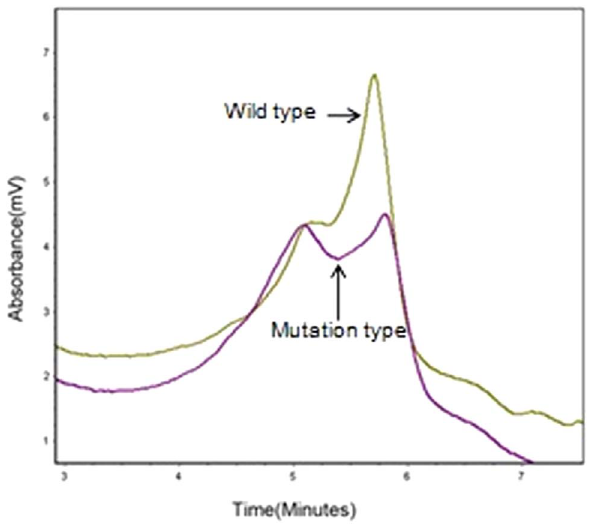
Figure 3. DHPLC shows wave pattern of wild type and mutant type PKHD1 . Wild type: from normal individuals. Mutant type : from affected individuals.